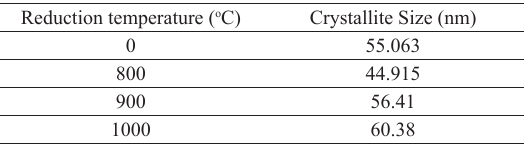
Table 2. Crystallite Size (nm) of reduced iron powder at different reduction temperatures.